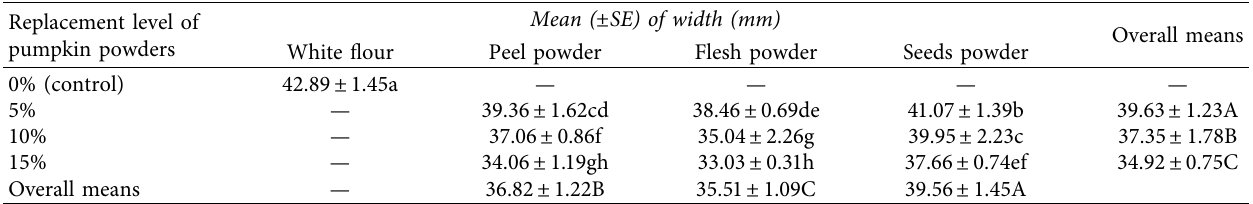
Table 7: Width (mm) of biscuits with diferent replacement levels of pumpkin peel, fesh, and seed powders. Replacement level of pumpkin